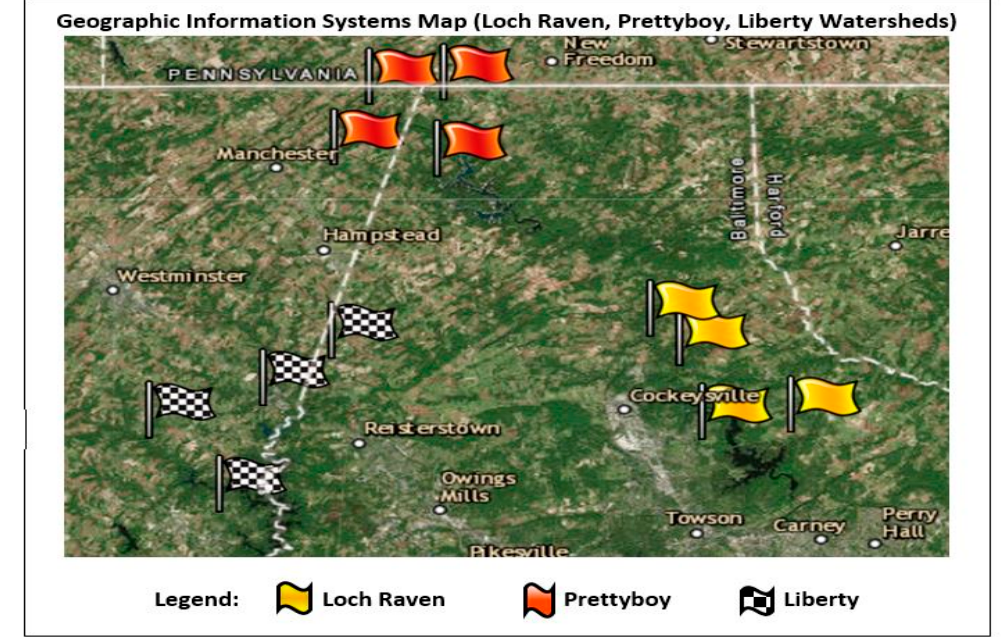
Figure 4. Map showing representative test points in the Liberty, Loch Raven and Prettyboy watersheds.